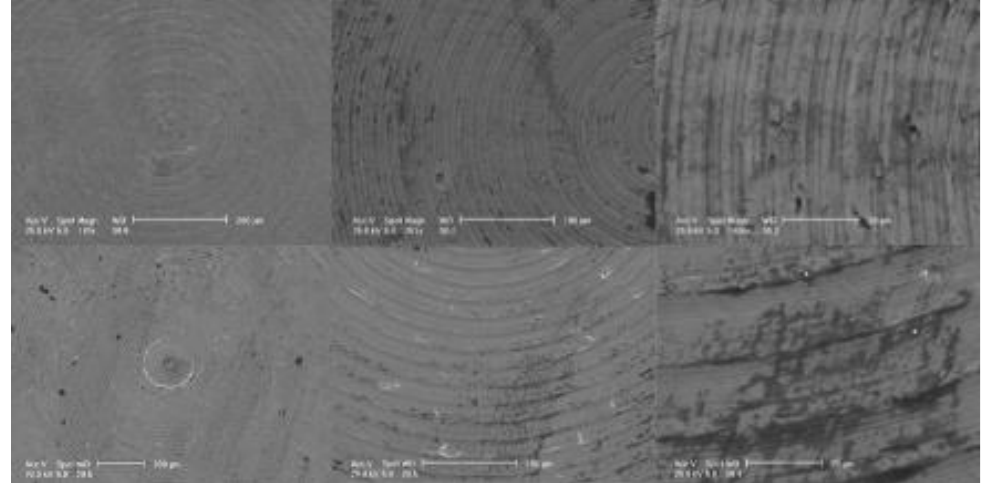
Figure 1. SEM analysis. The images of T1 (top) and T2 (bottom) were acquired at different level of magnification: 150×, 1000×, and 3000×.